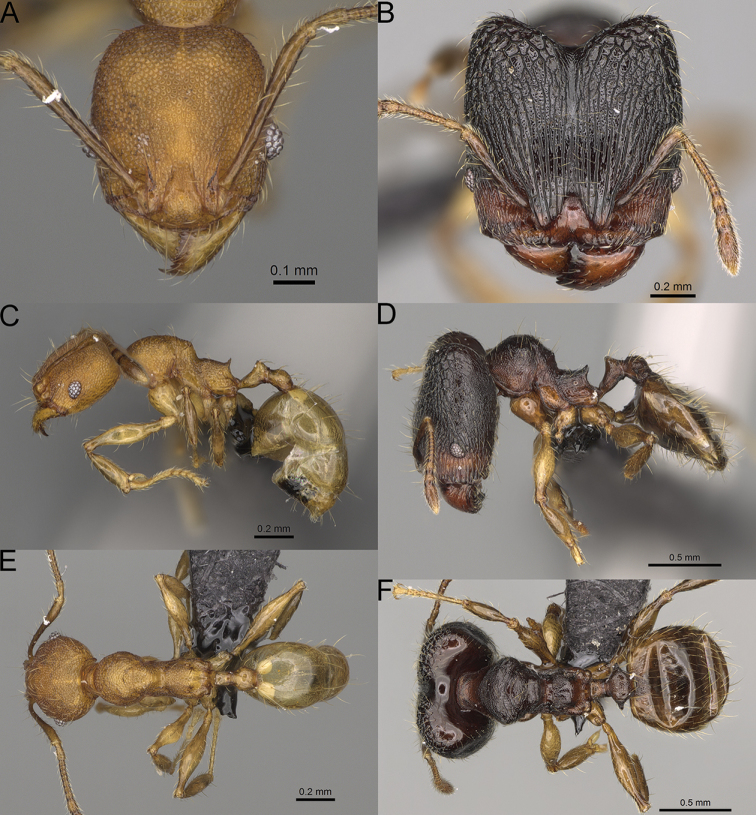
Pheidole
andapa sp. nov., full-face view (A), profile (C), and dorsal view (E) of paratype minor worker (CASENT0923178) and full-face view (B), profile (D), and dorsal view (F) of holotype major worker (CASENT0068047).